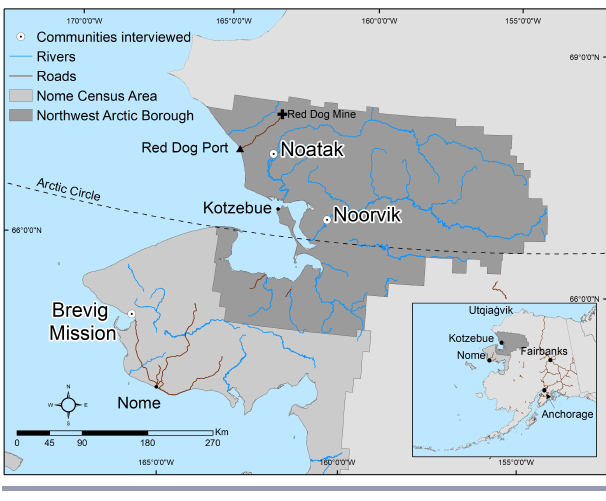
Fig. 1 . Three Alaska communities where interviews about technology and society were conducted in March